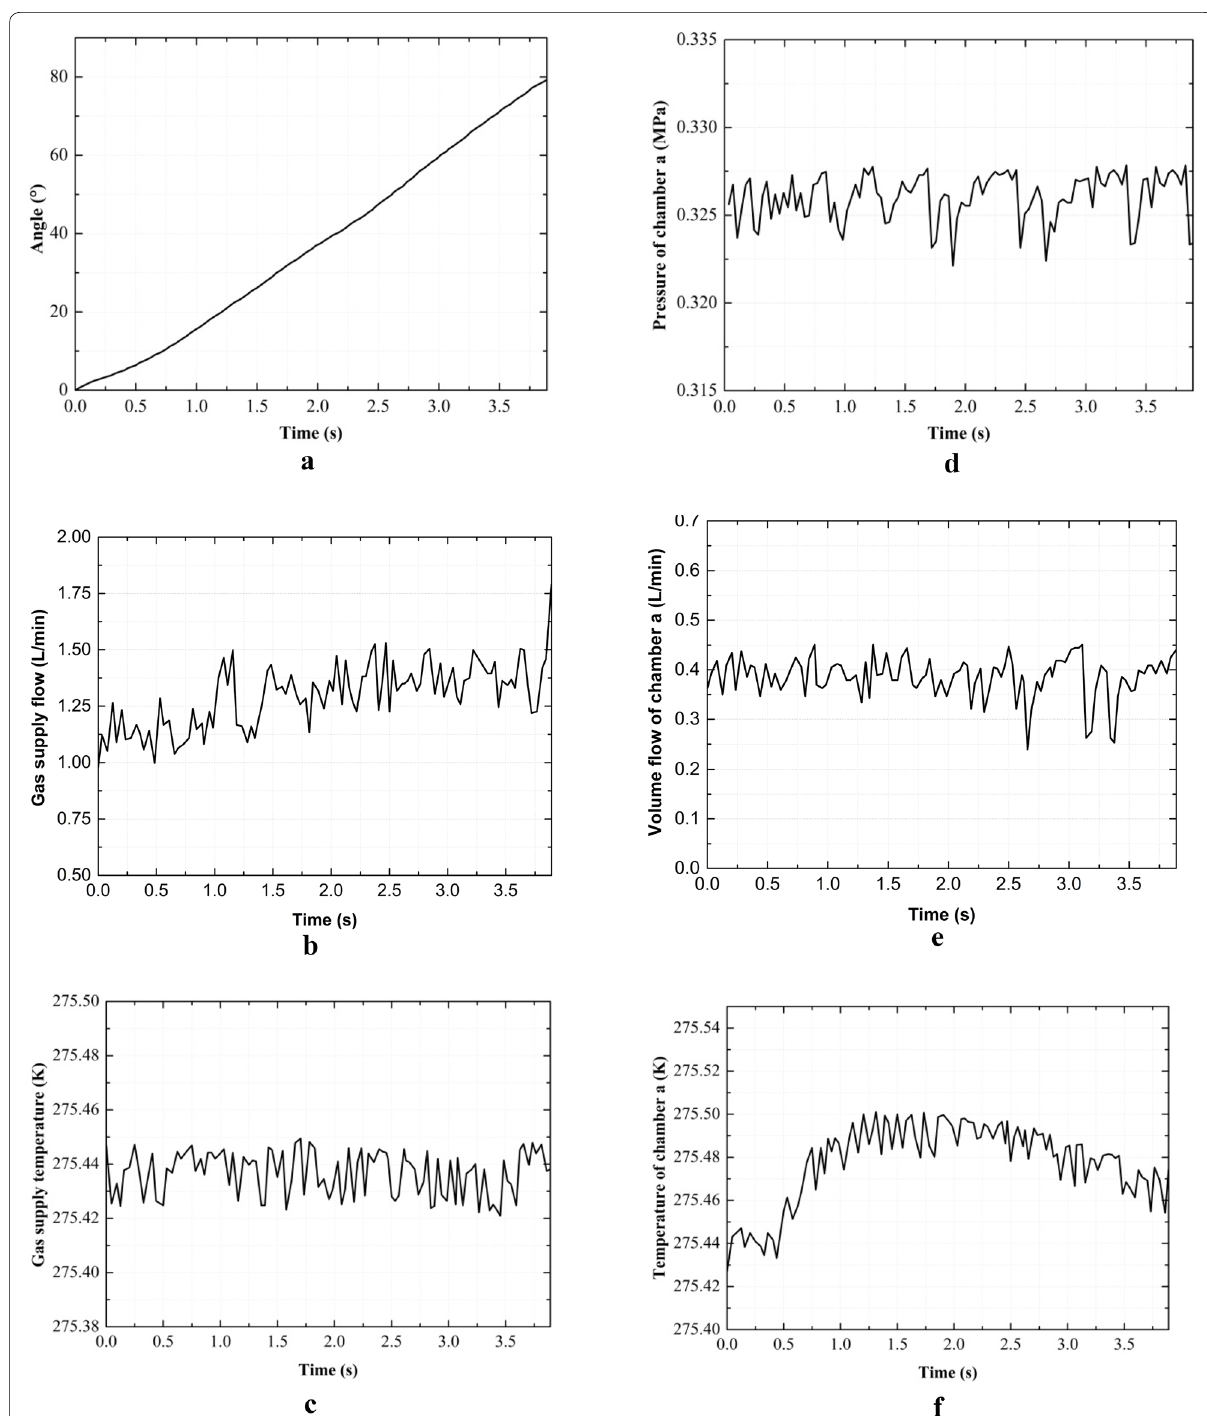
Figure 10 System response curve at gas supply pressure of 0.3367 MPa: ( a ) Angle curve, ( b ) Gas supply flow, ( c ) Gas supply temperature, ( d ) Pressure curve of Chamber a , ( e ) Volume-flow curve of Chamber a , ( f ) Temperature curve of Chamber